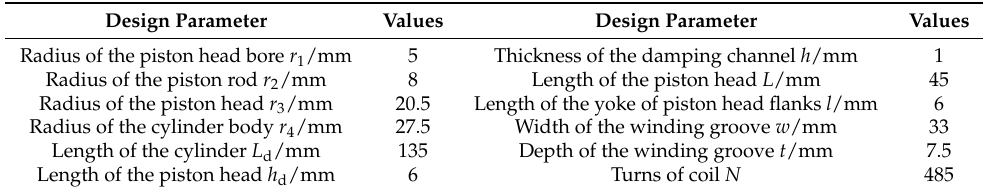
Table 1. Parameters of the self-powered MR